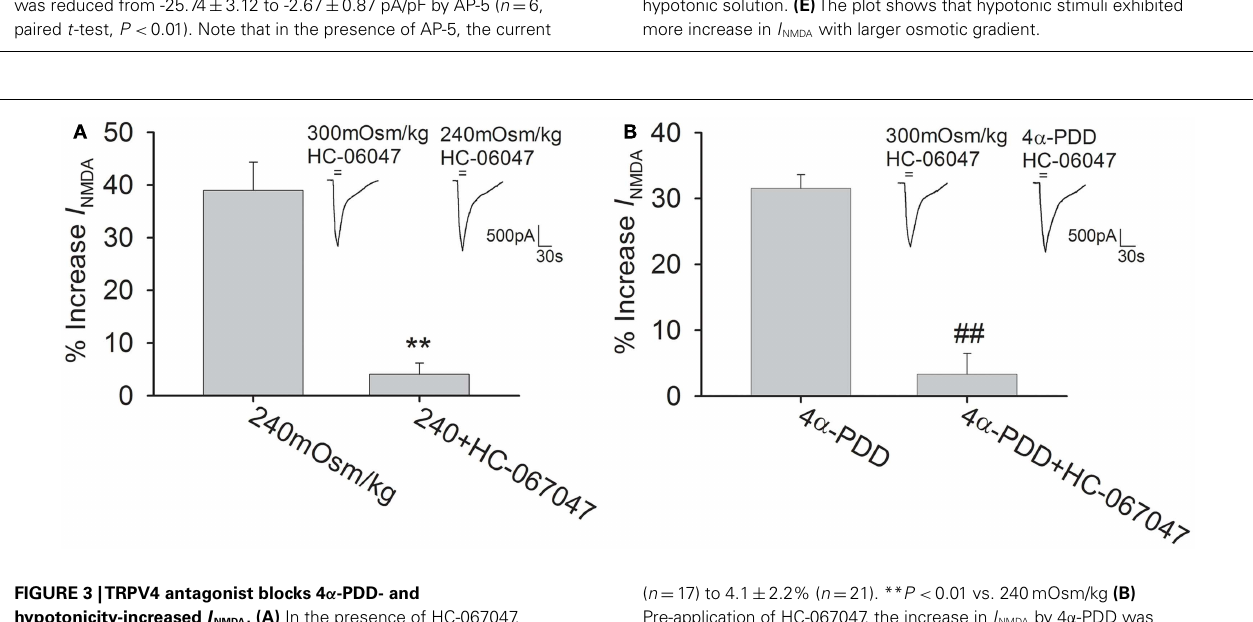
FIGURE 3 |TRPV4 antagonist blocks 4 α -PDD- and hypotonicity-increased I NMDA . (A) In the presence of HC-067047, I NMDA was almost not changed by hypotonic stimulation and the increase in I NMDA by hypotonicity was decreased from 39.0 ± 5.4%